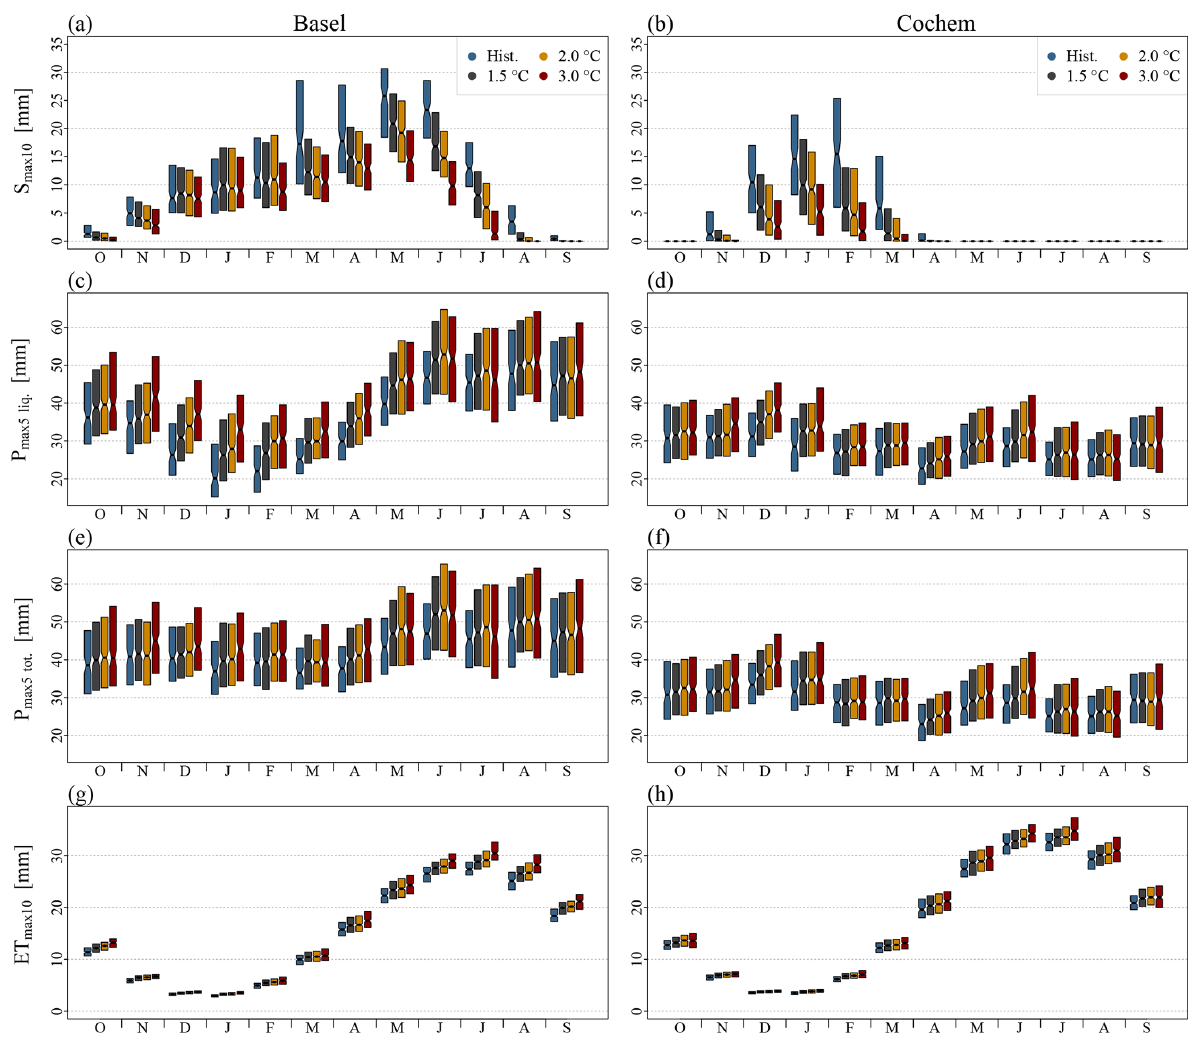
Figure 9. Magnitudes of 10d snowmelt maxima ( S max10 ; a and b ), liquid (c, d) and total (e, f) 5d precipitation ( P max5 ) and 10d actual evap- otranspiration maxima (ET max10 ; g and h ) for sub-basins at Basel and Cochem under selected warming levels (14 GCM–RCP realisations reach 1.5 ◦ C, 13 reach 2 ◦ C and 8 reach 3 ◦ C warming). Whiskers and outliers of the box plots are not